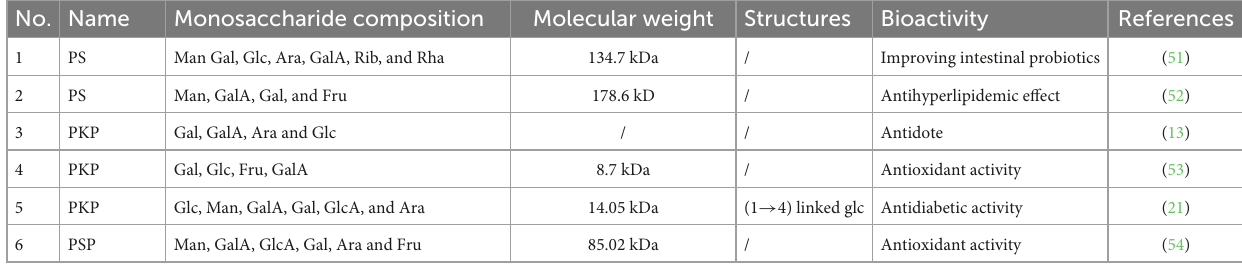
TABLE 3 The polysaccharides isolated from Polygonatum kingianum